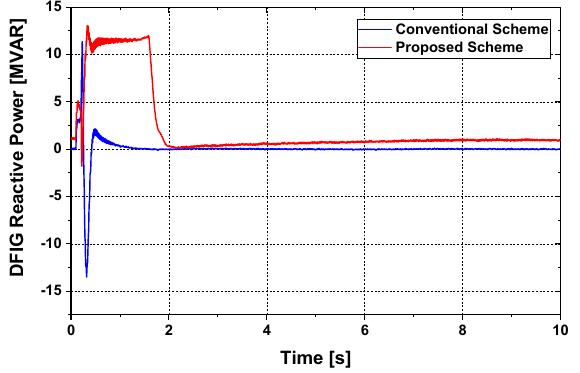
Figure 9. Reactive power response of DFIG.